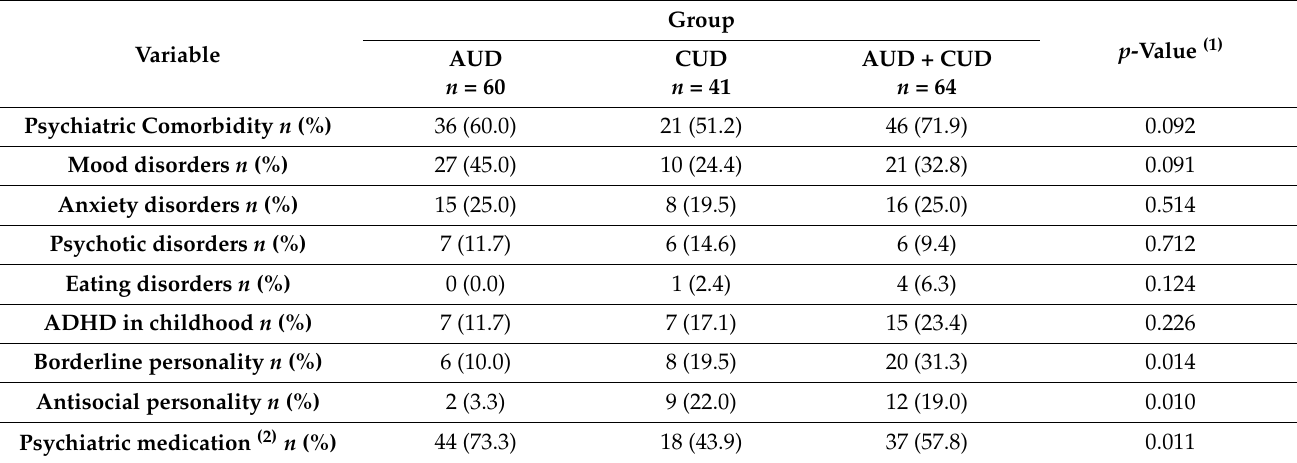
Table 3. Prevalence of comorbid psychiatric disorders.